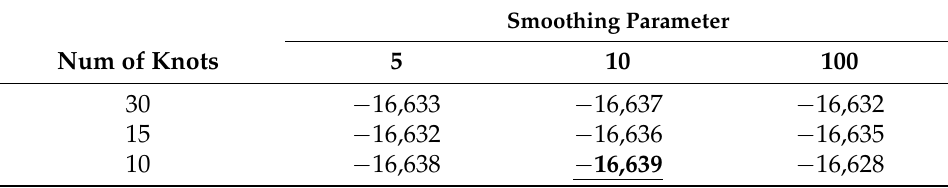
Table 13. DIC for Weibull distribution (23 June 2016, AGH, Tokyo, Japan).